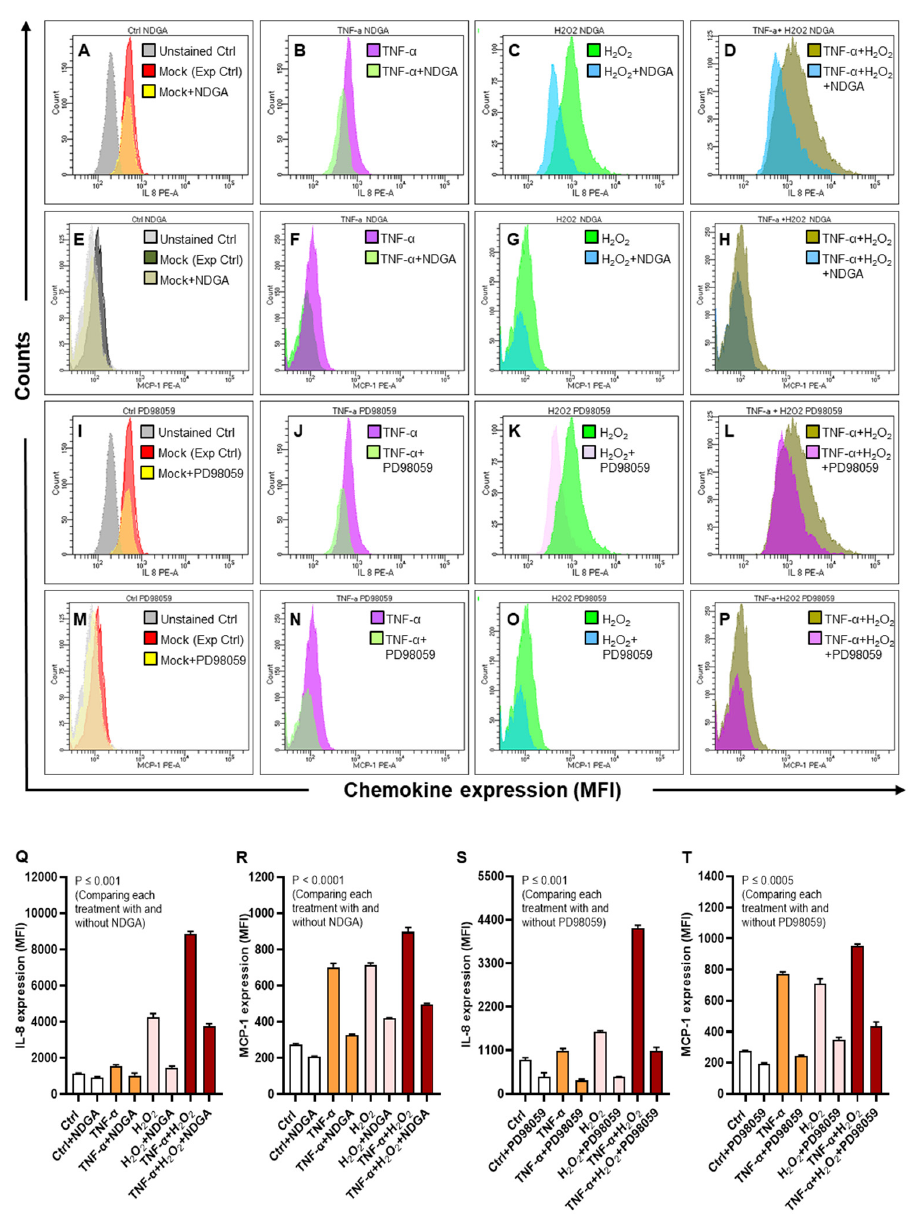
Figure 10. Inhibition of the NF- κ B and ERK-1/2 activation suppresses the expression of IL-8 and MCP-1. THP-1 cells were pre-incubated for 1 h, in triplicate wells, with NF- κ B inhibitor NDGA (30 µ M) and ERK1/2 inhibitor PD98059 (10 µ M), TNF- α (10. ng/mL) and/or H 2 O 2 (10 mM) for 24 h, while control cells were treated with vehicle only. IL-8 and MCP-1 protein expression, expressed as mean fluorescence intensity (MFI), was measured using flow cytometry as described in materials and methods. One-way ANOVA (Tukey’s multiple comparisons test) was used to calculate group differences and p -values less than 0.05 were considered as significant. The representative histograms from three independent determinations with similar results show the comparative expression of ( A – D ) IL-8 and ( E – H ) MCP-1 in cells stimulated with TNF- α and/or H 2 O 2 , including control, with and without NDGA. Similarly, representative histograms from three independent determinations show the comparative expression of ( I – L ) IL-8 and ( M – P ) MCP-1 in cells stimulated with TNF- α and/or H 2 O 2 , including control, with and without PD98059. Quantitative analysis of the data (mean ± SEM) shows significant suppression of ( Q ) IL-8 ( p ≤ 0.001) and ( R ) MCP-1 ( p < 0.0001) in cells co-stimulated after pre-treatment with NDGA; as well as diminution of ( S ) IL-8 ( p ≤ 0.001) and ( T ) MCP-1 ( p ≤ 0.0005) in cells co-stimulated after pre-treatment with PD98059, as compared to respective controls without incubation with the pathway